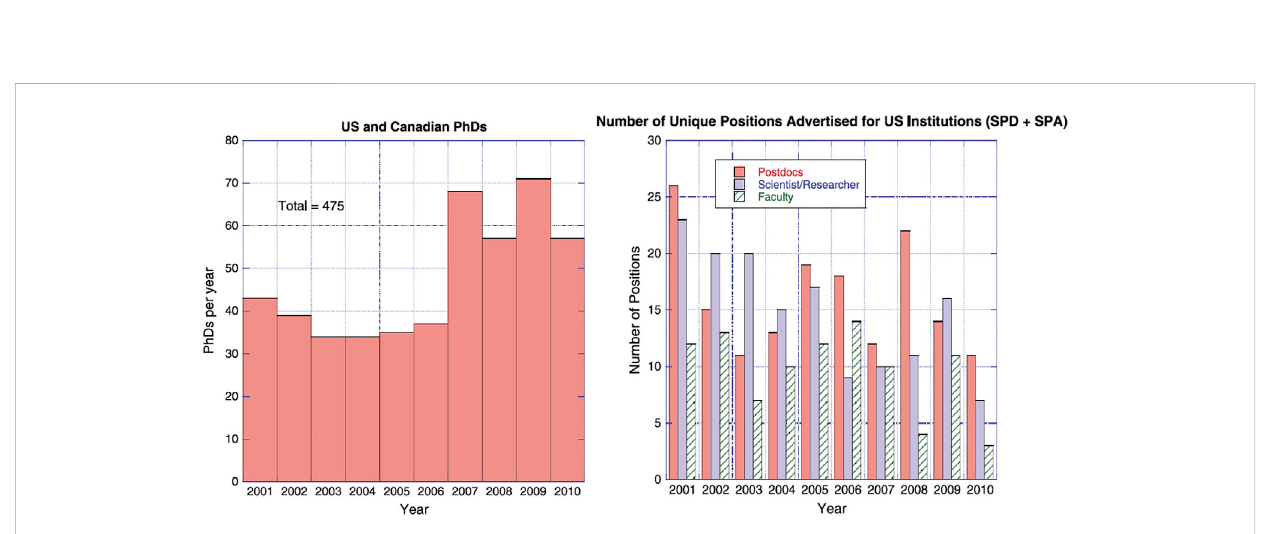
FIGURE 2 Total PhDs in solar and space physics (2001 – 2010) and number of unique positions advertized ( via solar and space physics newsletters) for US institutions at levels of postdoc, research scientist and faculty. (Moldwin et al.,